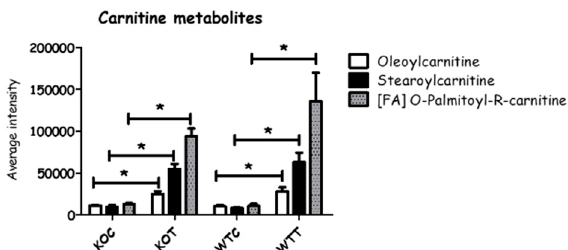
Figure 6. Some carnitine metabolites were changed between different groups. KOT: TSPO knockout cells with the treatment of oxLDL; KOC: TSPO knockout cells without the treatment of oxLDL; WTT: Wildtype cells with the treatment of oxLDL; WTC: Wildtype cells without the treatment of oxLDL. * Indicates that difference is significant with corrected p < 0.05. Error bar is the standard error of the mean (SEM).